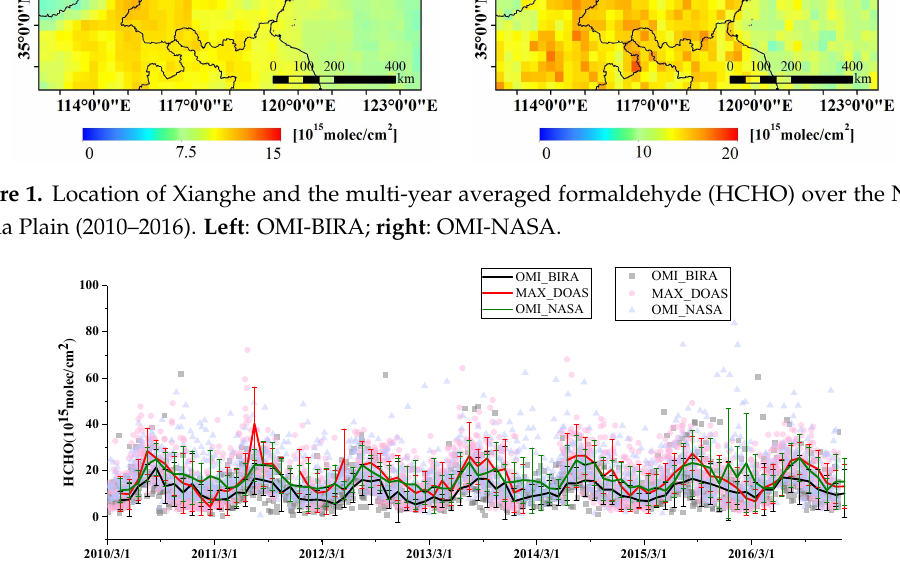
Figure 2. Daily averaged and monthly averaged OMI-BIRA, OMI-NASA and MAX-DOAS data.